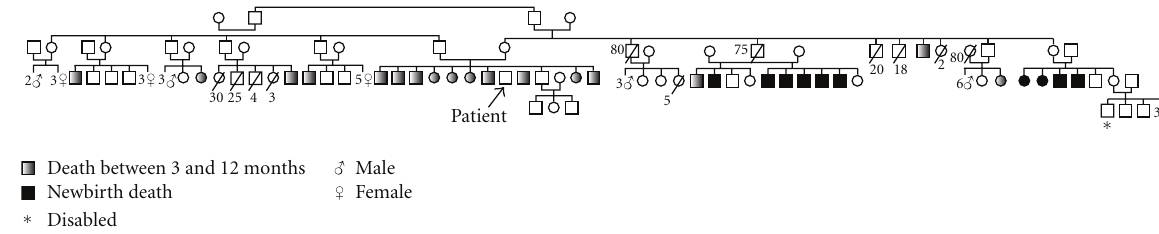
Figure 1: Patient’s family tree. For representativeness of this large family, safe progenies are represented by female or male symbol preceded by the number of subjects. Numbers noted close to dead subjects indicate age at death.